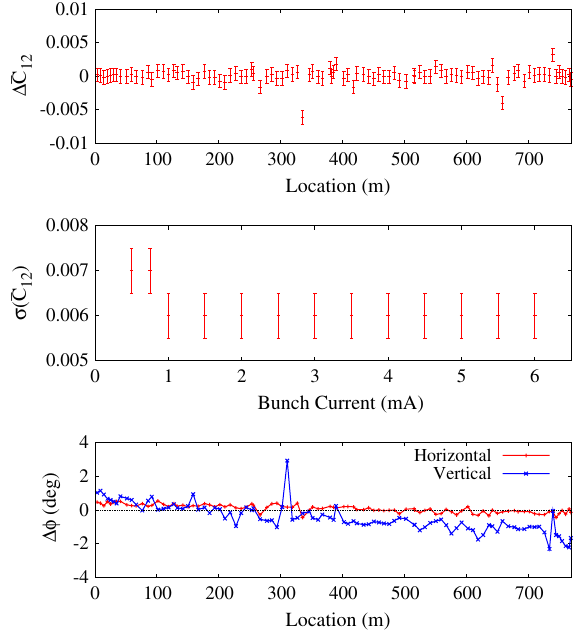
FIG. 15. Top: Difference in transverse coupling at 6 mA vs 0.8 mA single-bunch current measured at each BPM. Middle: Current dependence of rms ð (cid:8) Þ of residual coupling of all N P ð (cid:1) C Þ 2 . Bottom: Difference in be- N ¼ 100 BPMs where (cid:8) 2 ¼ 1 i 12 i ¼ 1 N tatron phase at 6 mA vs 0.8 mA single-bunch current. The downward trend in the vertical corresponds to the current- dependent tune shift. (cid:4) is related to the phase advance from one BPM to the next. The fractional change in (cid:4) from 6 to 0.8 mA is less than